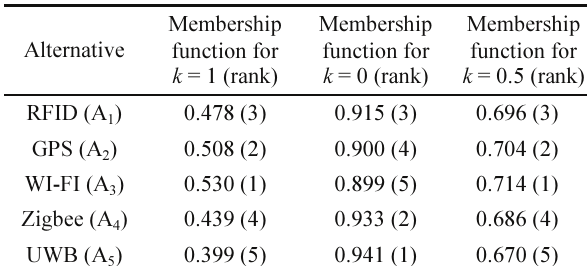
Table 5. Ranking values from the FAI on five alternatives according to the decision maker’s attitude ( k = 1 for optimist, k = 0 for pessimist, and k = 0.5 for neutral person) Membership Membership Membership Alternative function for function for function